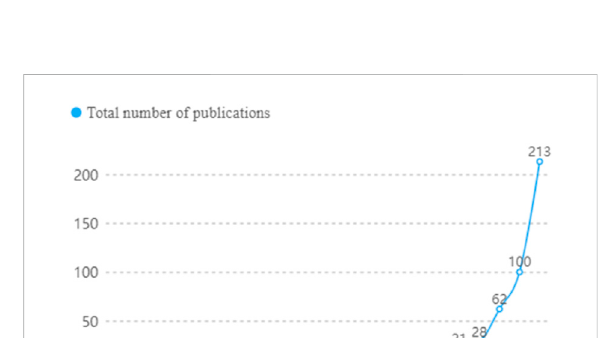
FIGURE 2 Number of studies on health risks of soil microplastics in different